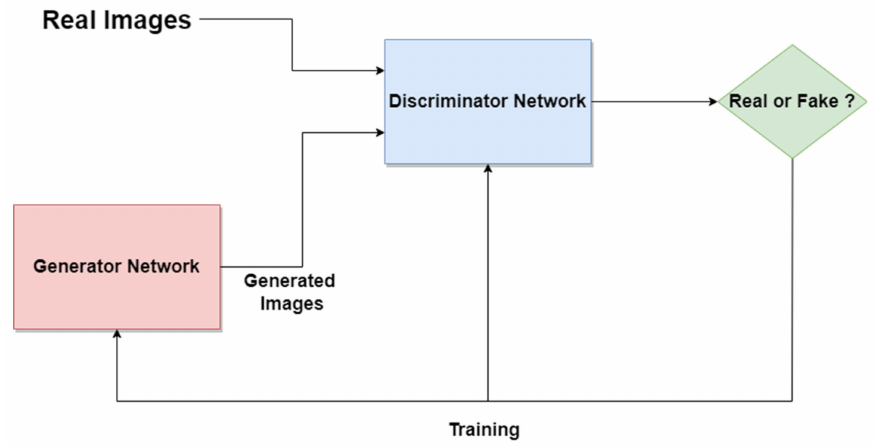
Figure 22. GAN standard network architecture.